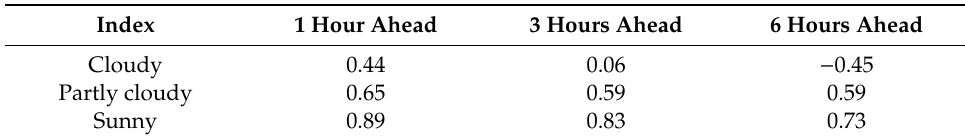
Table 5. LSTM performances in terms of NSE for cloudy, partly cloudy and sunny days (daytime LSTM performances in terms of NSE for cloudy, partly cloudy and sunny days samples only). (daytime samples only).